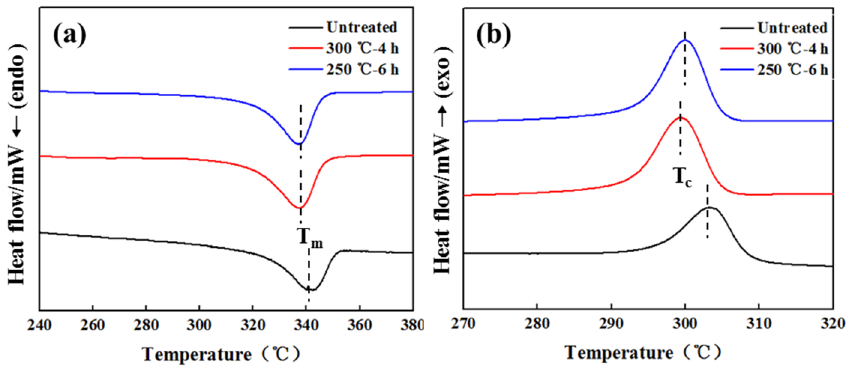
Figure 5. DSC curves of CF/PEEK under different heat treatment processes: (a) first, heating scan, (b) cooling scan. Heating rate and cooling rate are both set to 10 °C/min. Table 2. Thermal performance parameters of CF/PEEK under different heat treatment processes. Samples